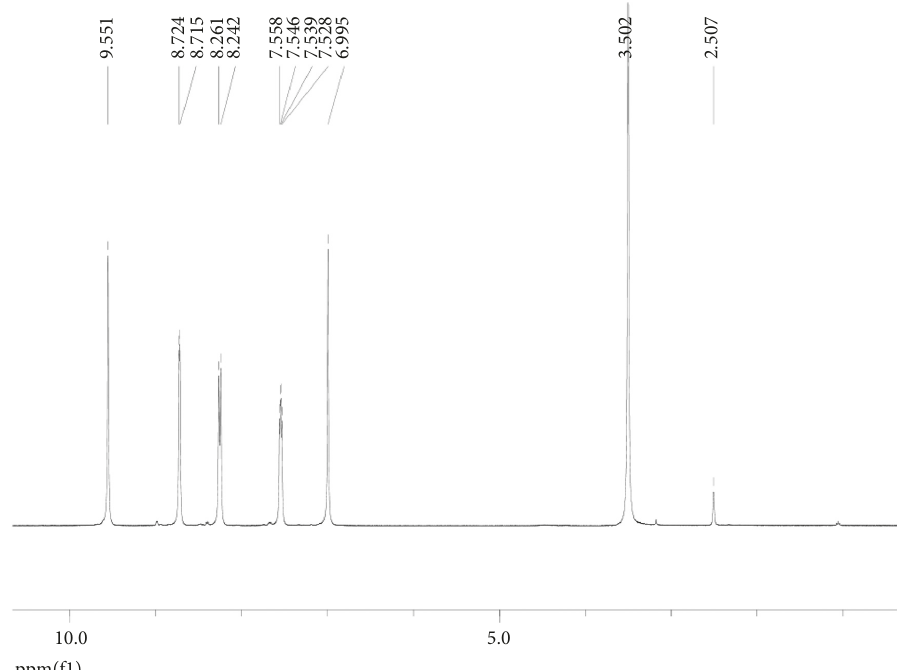
Figure 2: 1 H NMR spectrum of ligand 1,10-PDTU in DMSO.